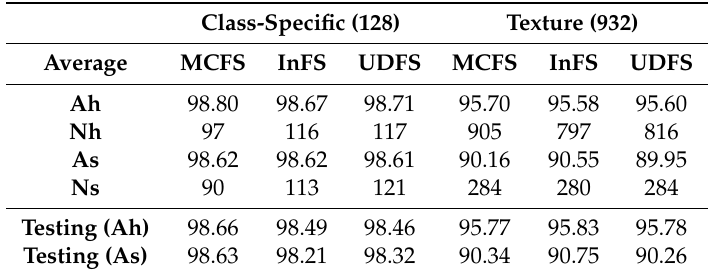
Table 7. Unsupervised features selection methods: Experimental protocol 2.